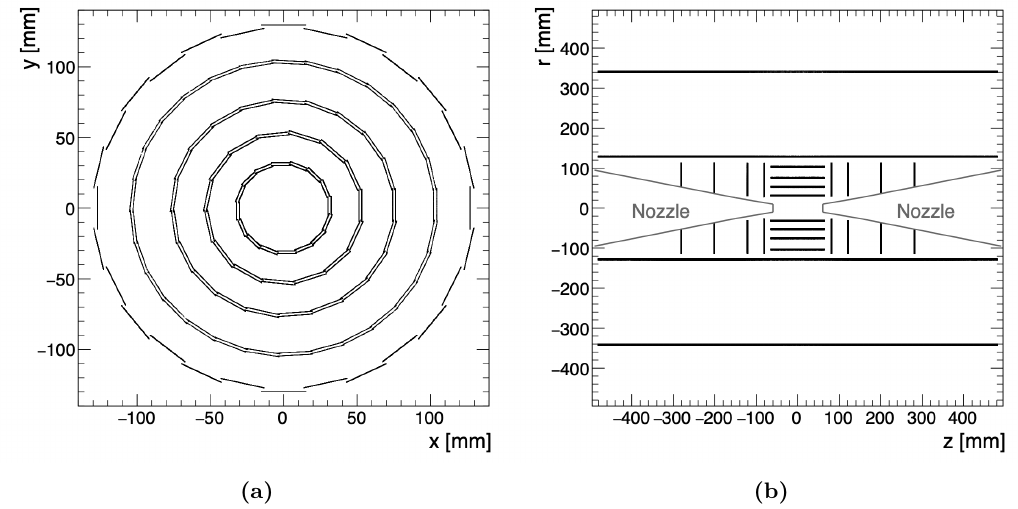
Figure 4. Transverse (a) and longitudinal (b) views of the innermost region of the tracking detectors. In the left panel, one can visualise the four concentric cylindrical double-layers of the VXD and the innermost layer of the IT. These appear also in the right panel along with the four double-layer VXD endcap disks and the second layer of the